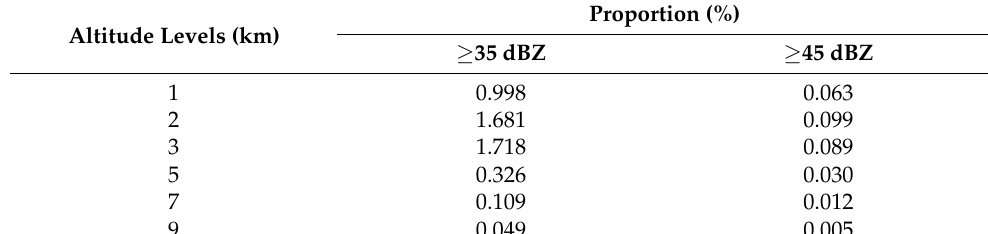
Table 7. Reflectivity statistics in the test set.